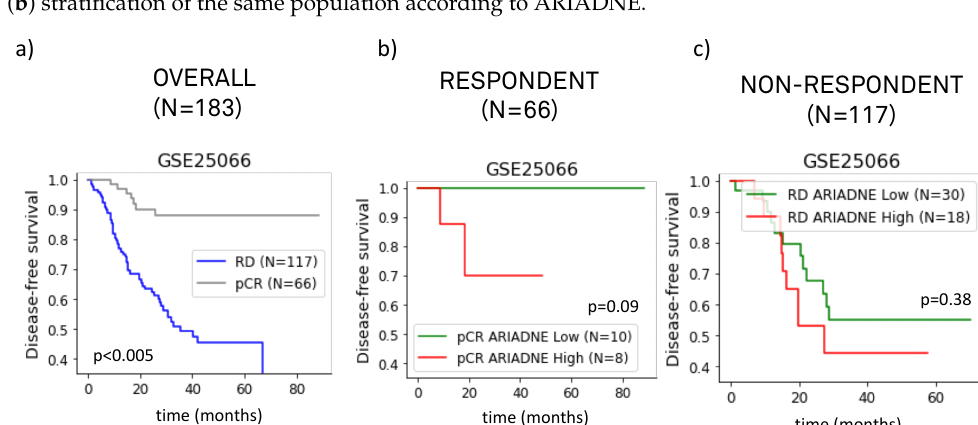
Figure 2. Response to neoadjuvant chemotherapy for different ARIADNE groups for dataset GSE25066: ( a ) percentage of patients with pathological complete response for the three different ARIADNE groups compared with the baseline provided by the entire population, the difference be- tween the ARIADNE-low group and the rest of the patients was not statistically significant ( p = 0.07); ( b ) stratification of the same population according to ARIADNE.